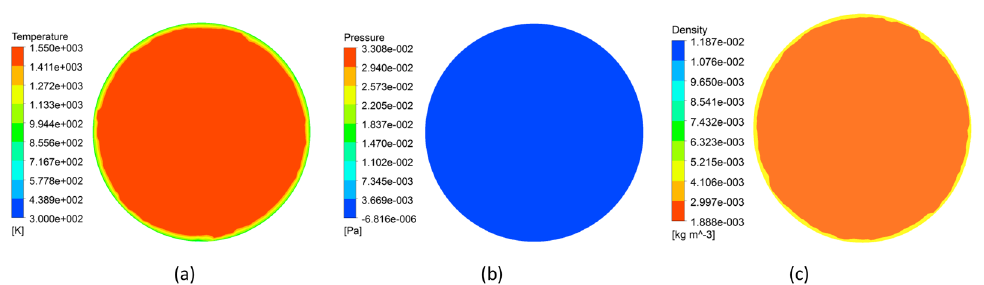
Figure 5. Distributions of fields on the substrate. ( a ) temperature ( b ) pressure ( c )